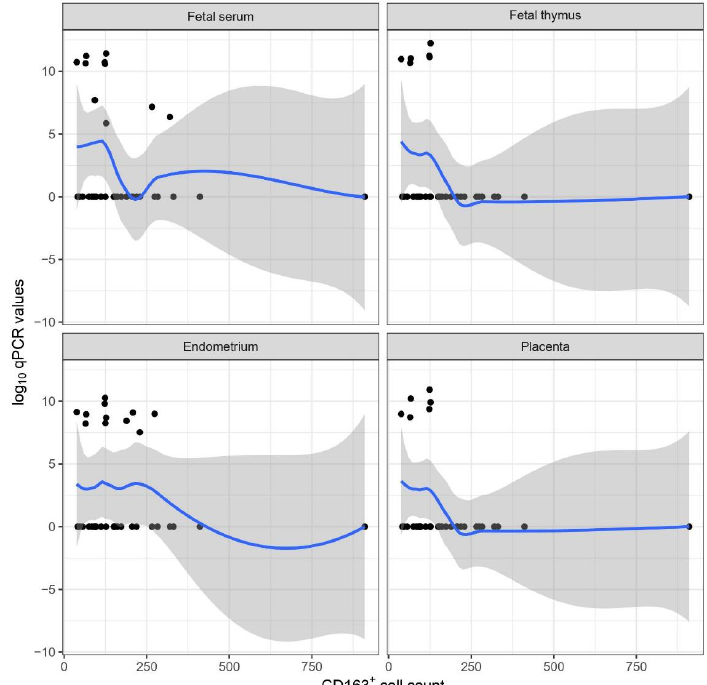
Figure 11. Scatterplot on the association between CD163+ cell counts and log10 qPCR values of the fetal serum, fetal thymus, endometrium, and placenta samples.